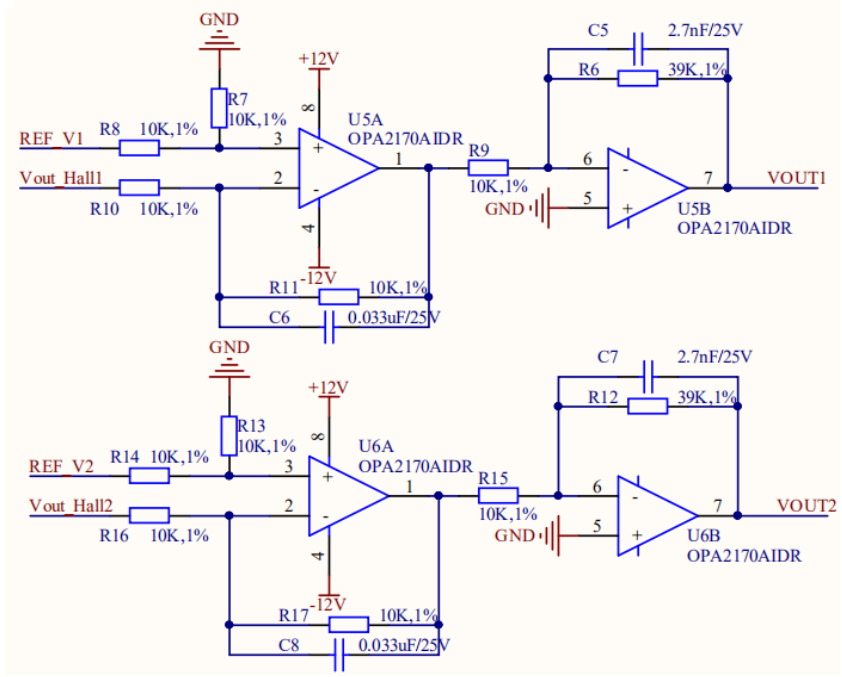
Figure 4. The Hall power supply circuit of the VCM.